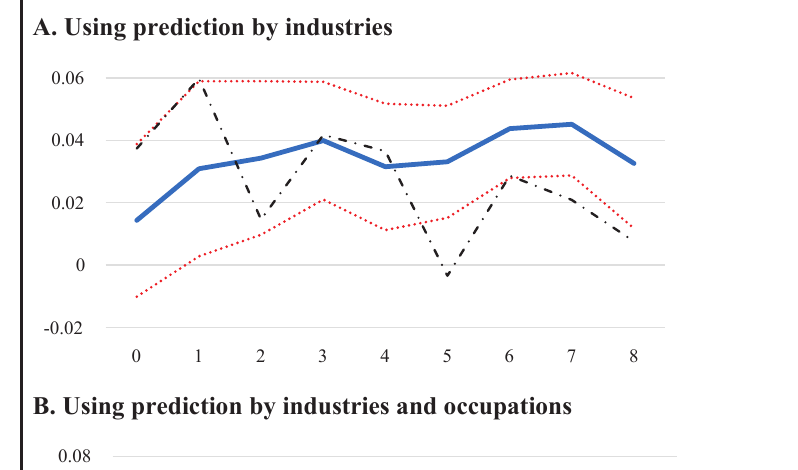
Figure 7 Response of predicted female share of employment during